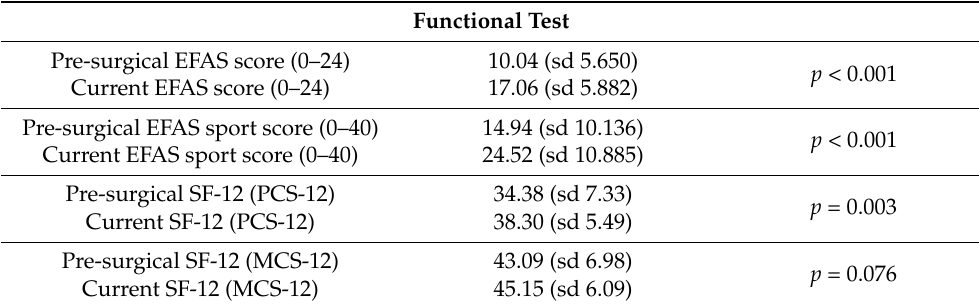
Table 4. Presurgical vs Current functional test (Wilcoxon